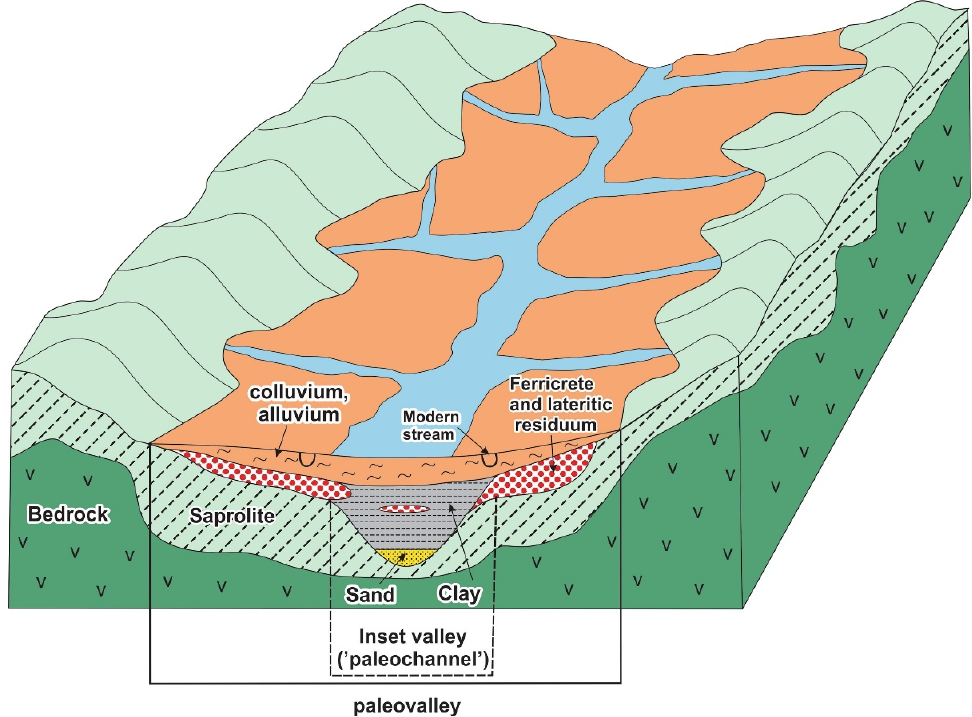
Figure 1. Location of Au-enriched ferricrete units in paleovalley systems (adapted with permission from Ref. [3]. Copyright 2022 Elsevier).